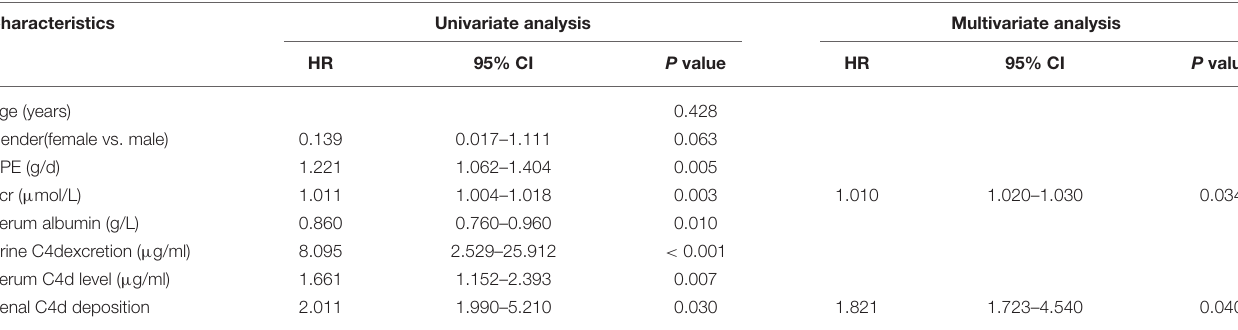
TABLE 7 | Univariate and multivariate Cox regression analysis for predictors of disease progression during the follow-up period for IgAN patients. Characteristics